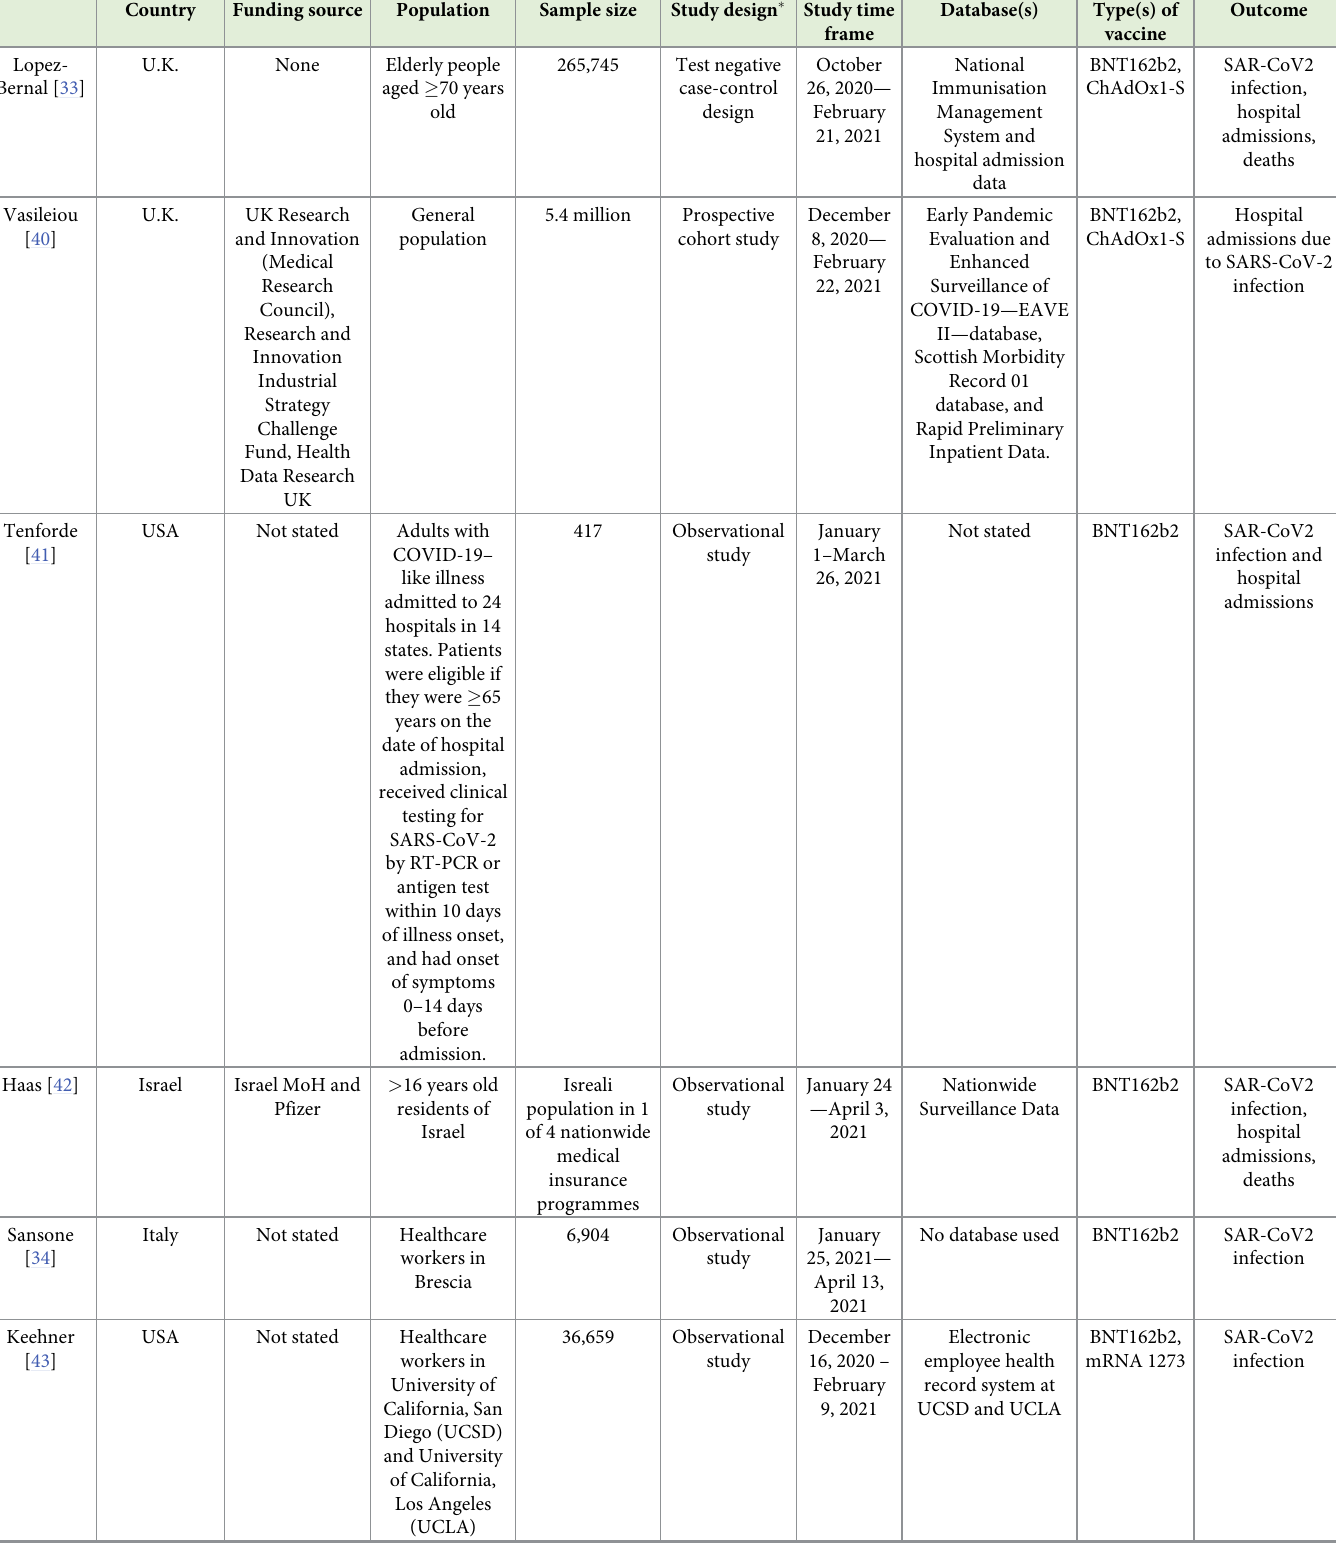
Table 2. Characteristics of COVID-19 vaccine real-world effectiveness studies meeting inclusion criteria.